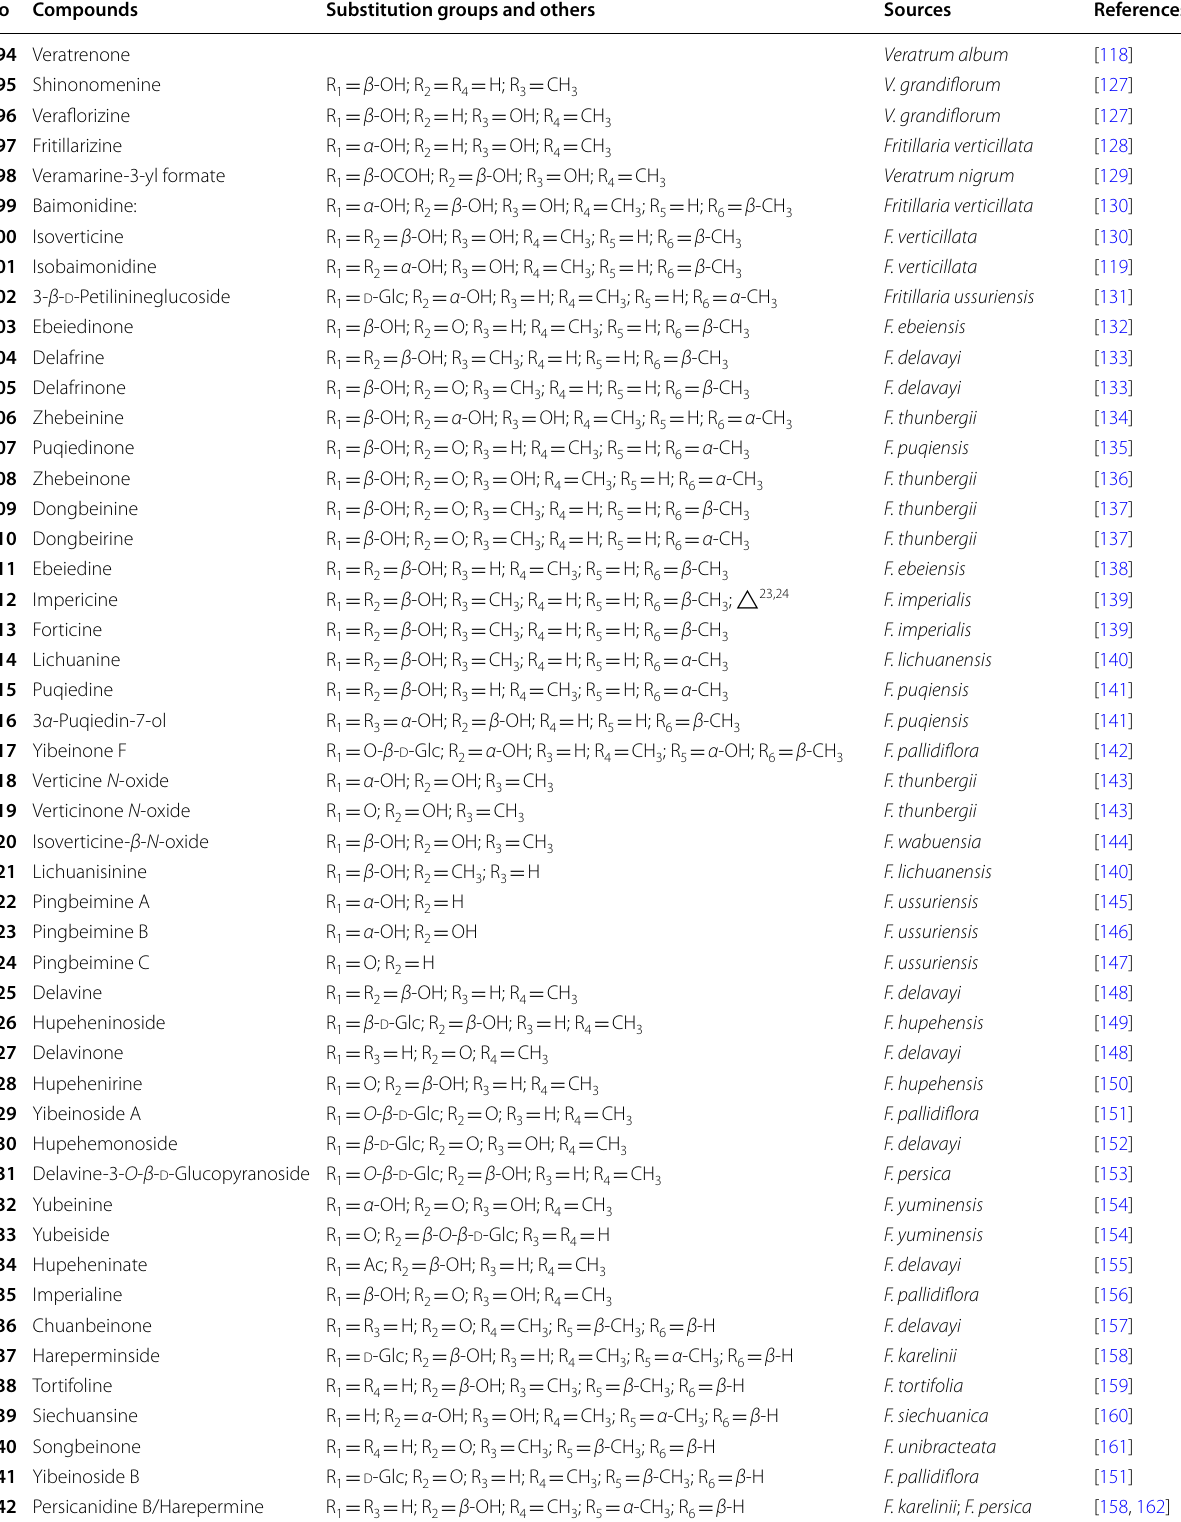
Table 6 Structures and sources of cevanine type steroidal alkaloids 294–384 No Compounds Substitution groups and